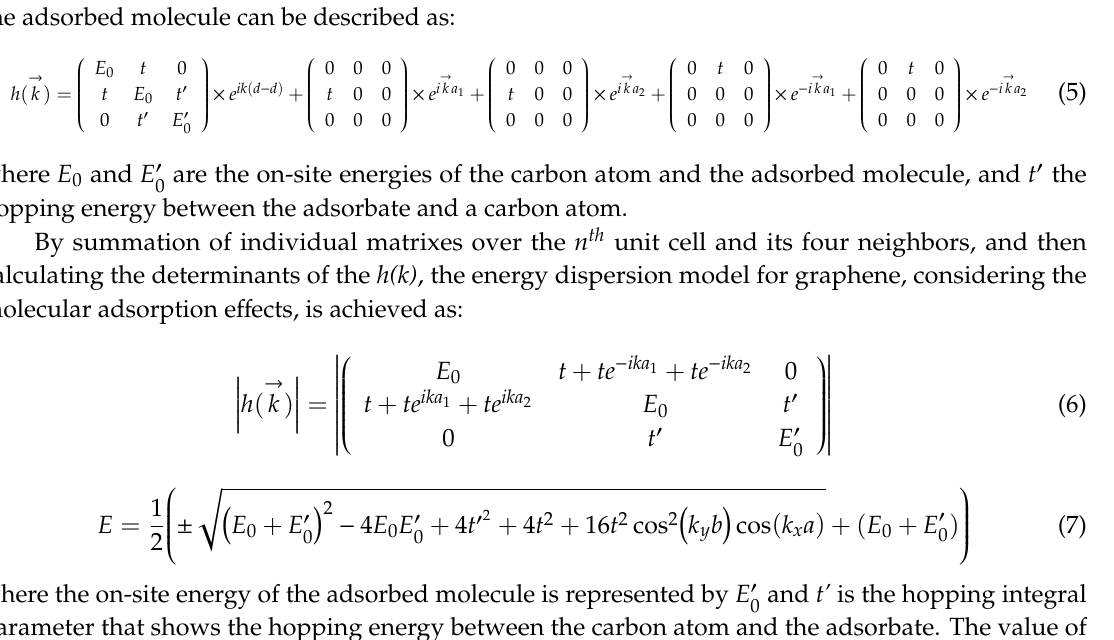
Figure 3. Molecular adsorption on graphene’s n th unit cell and neighbor unit cells.